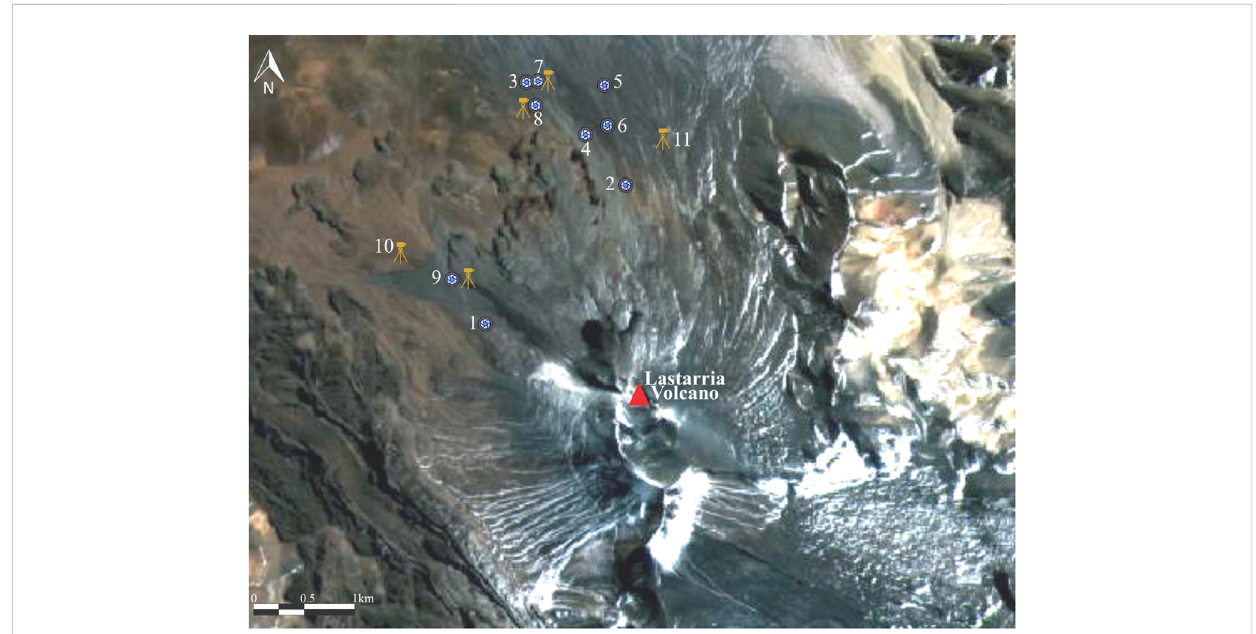
FIGURE 2 Location of measurements with UV Picam and DOAS at Lastarria volcano. The blue and black circle correspond to locations of UV Picam measurements, and the yellow tripods correspond to DOAS measurements. The numbers correspond to the correlative location points in the Table